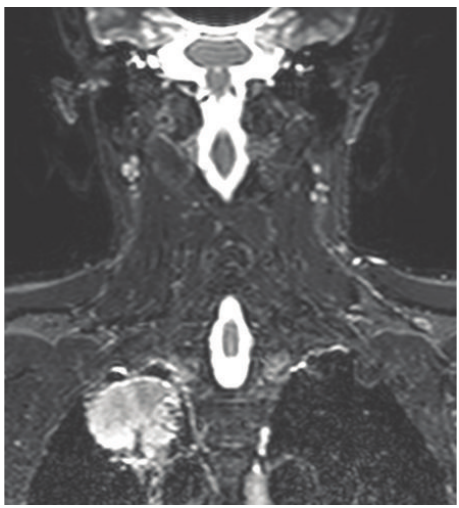
Figure 7: In this STIR image on the coronal plane it is showed a round-shaped lesion without an invasion of the superior sulcus. STIR sequences provide a better signal homogeneity, but they have a lower SNR.